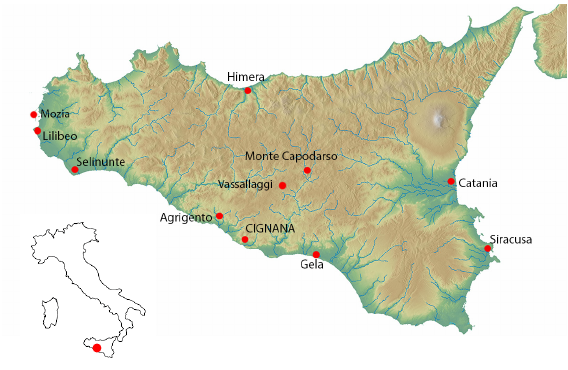
Figure 1. The area of Cignana.